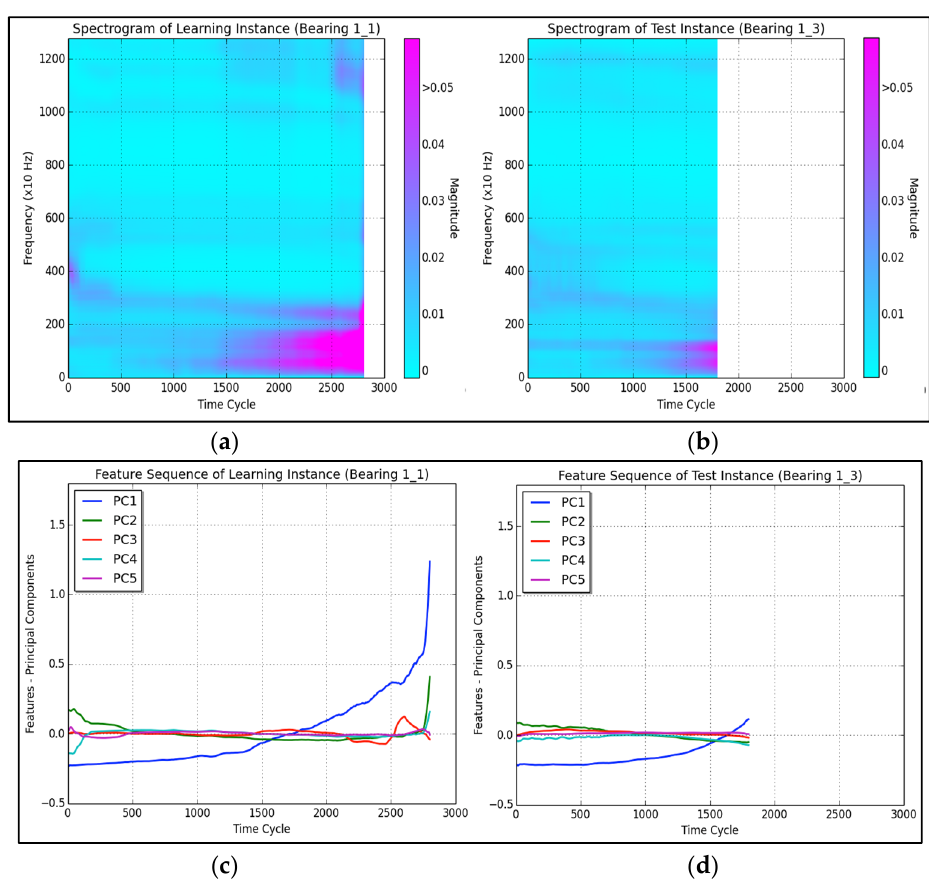
Figure 3. Spectrograms and PC feature sequences: ( a , c ) learning instance Bearing1-1; ( b , d ) test instance Bearing1-3.